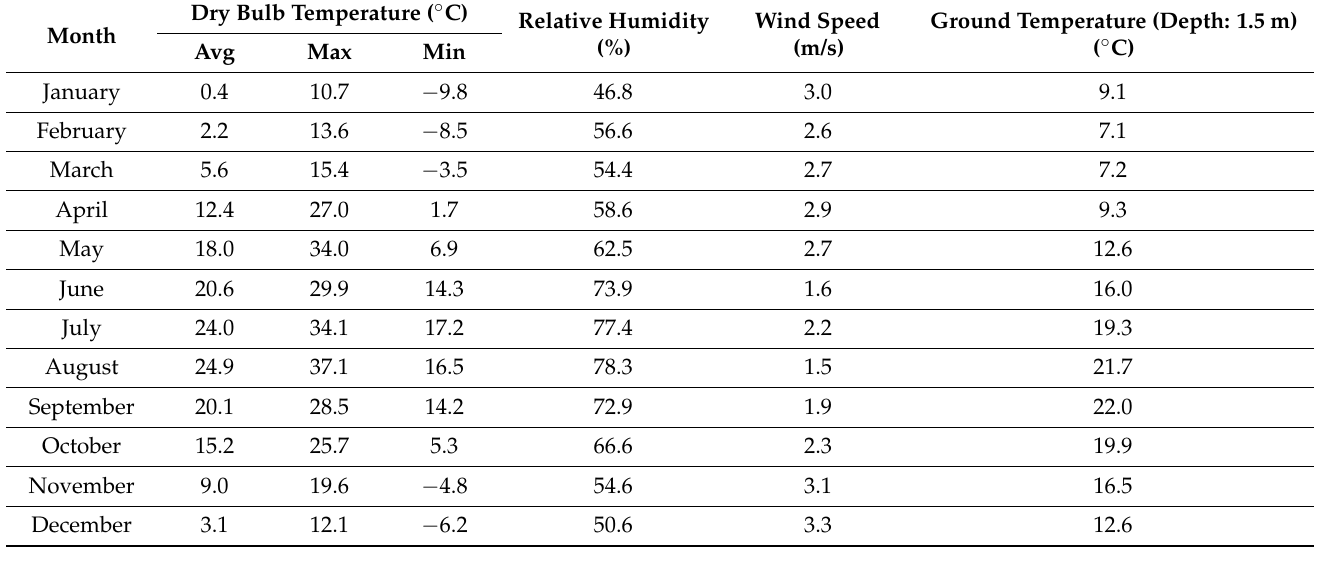
Table 4. Weather data used in the simulation model.